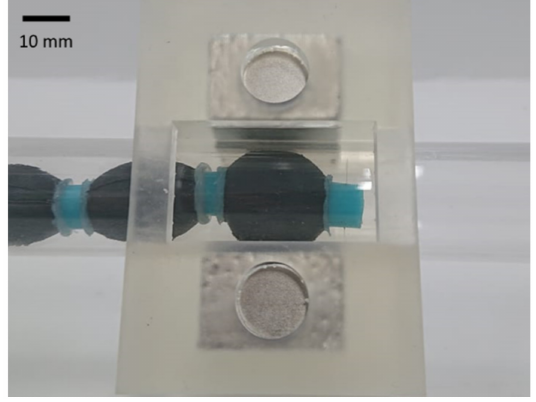
Figure 3. Deformed ellipsoid under external magnetic field.